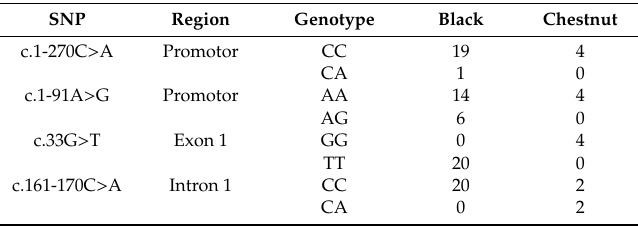
Table 2. Distribution of the four SNPs in the ASIP gene depending on coat color. SNP Region